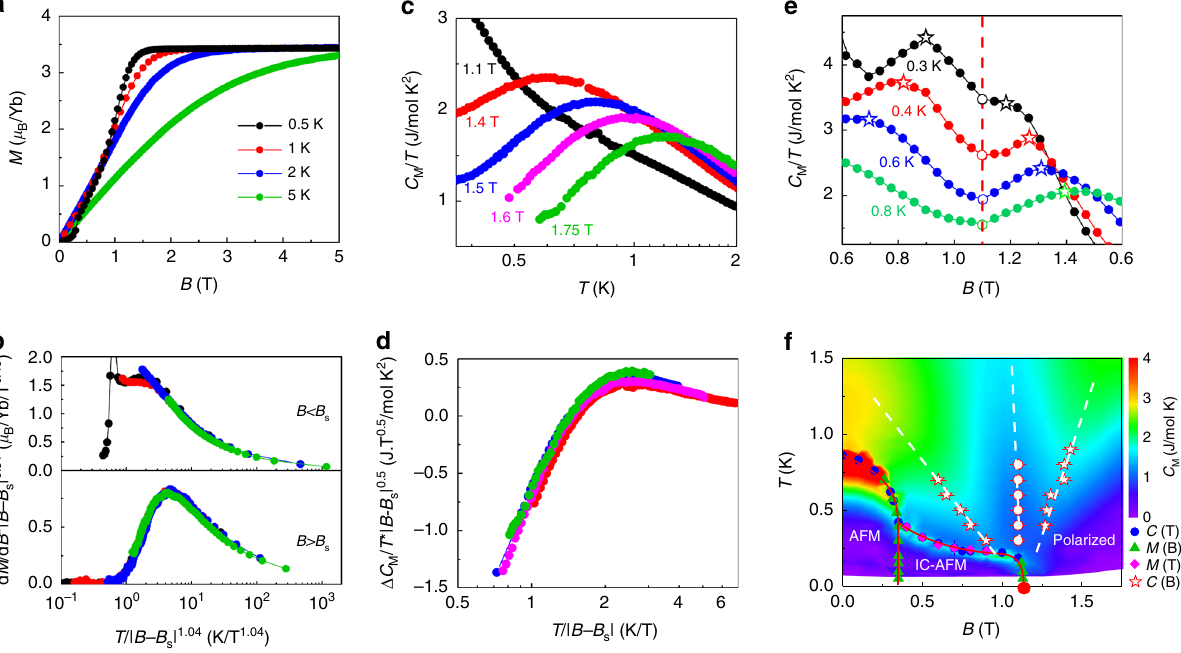
Fig. 7 Quantum critical scaling and universality of YbAlO 3 . a Field-dependent magnetization M measured at different temperatures. b Critical scaling of the magnetic susceptibility in a , for fi elds both below and above B s . c Temperature-dependent magnetic speci fi c heat C M / T measured at different fi elds. d Critical scaling of the fi eld-dependent magnetic speci fi c heat Δ C T shown in c . e Field-dependent magnetic speci fi c heat C T at different M / M / temperatures. The red dashed line indicates the saturation fi eld B s = 1.1 T at the minimum, and crossovers with two broad maximum shoulders are observed. f Contour plot of the magnetic speci fi c heat C M as a function of temperature and fi eld. Magnetic phase boundaries extracted through different measurements are over-plotted. The red circles indicate the saturation fi eld B s at different temperatures, and the empty stars indicate the crossover de fi ned through the fi eld-dependent speci fi c heat maxima